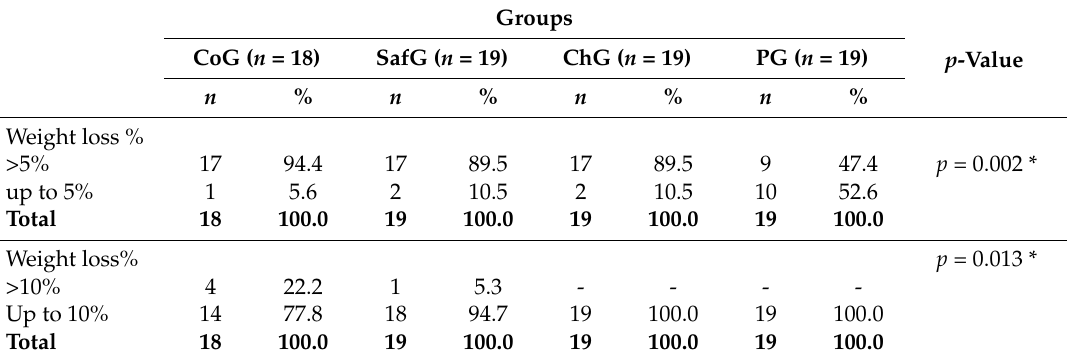
Table 2. Percentage of variation in weight loss of the participants.